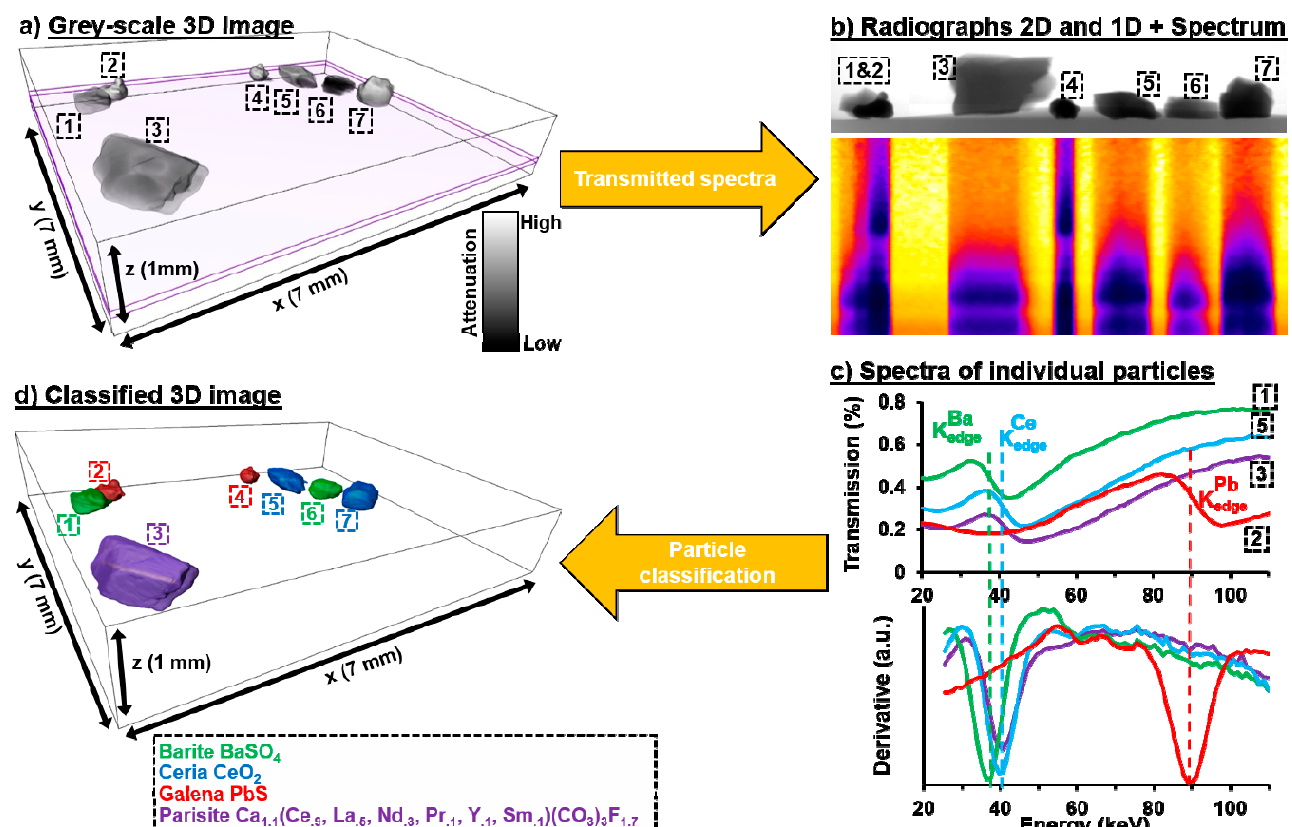
Figure 3. Classification of particles in a grey-scale 3D image ( a ) using spectral radiographs of individual particles ( b ). Note the correlation between the normal radiograph (grey) and the spectral radiograph (colour). The transmission spectrum and its derivate corresponding to individual particles are shown ( c ). Numbers and colours identify specific mineral phases that are correlated to classify the particles in the 3D images ( d ). The grey-scale in ( a ) is based on the total attenuation after a normal CT scan. Spectral plots are averaged values from all pixels representing each particle. Note that the spectra of some particles overlap in the example sp-radiograph shown; however, the data for the plots were taken from positions where the particles are not aligned (see Figure